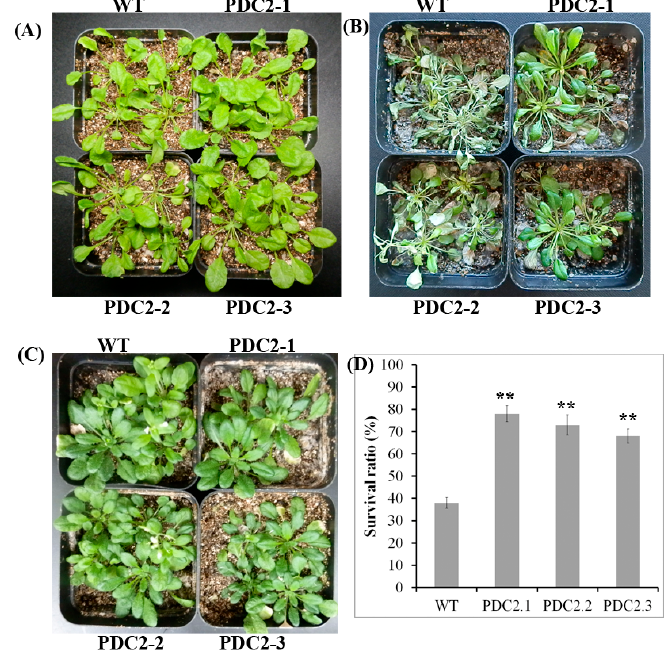
Figure 4. Phenotype of AdPDC2 transgenic Arabidopsis and WT lines under heat stress. ( A ) The five- Phenotype of AdPDC2 transgenic Arabidopsis and WT lines under heat week-old transgenic and WT plants were grown in nutrient soil before heat stress. ( B ) The seedlings were kept at 37 °C for three days, and then recovery for one week. ( C ) The seedlings were planted in normal growth conditions for 45 d (CK). ( D ) Survival rate of plants in B after heat stress. For D, each column is the average of three replicates and each replicate has 36 plants. Bars indicate SD. The data presented are mean ±SD; Double asterisks indicate significant differences compared with control line values ( ** p < 0.01).